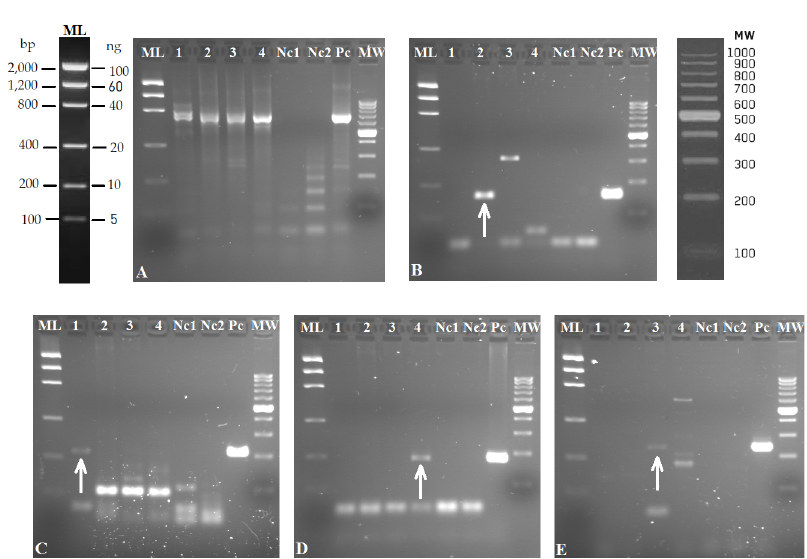
Fig 2. Agarose gels (2%) showing amplification products obtained from eDNA with the designed specific markers. PCR ampliconswith: A) universalprimers [48]; and specific primers for Corbiculasp . (B), Melanoides tuberculata (C), Mytilopsisleucophaeata (D); Sinanodontawoodiana (E). Lanes in all gels are: Mass ladder, 1-Alhama de Arago´n thermal lake, 2-Ebro River (Zaragoza), 3-Santillana reservoir